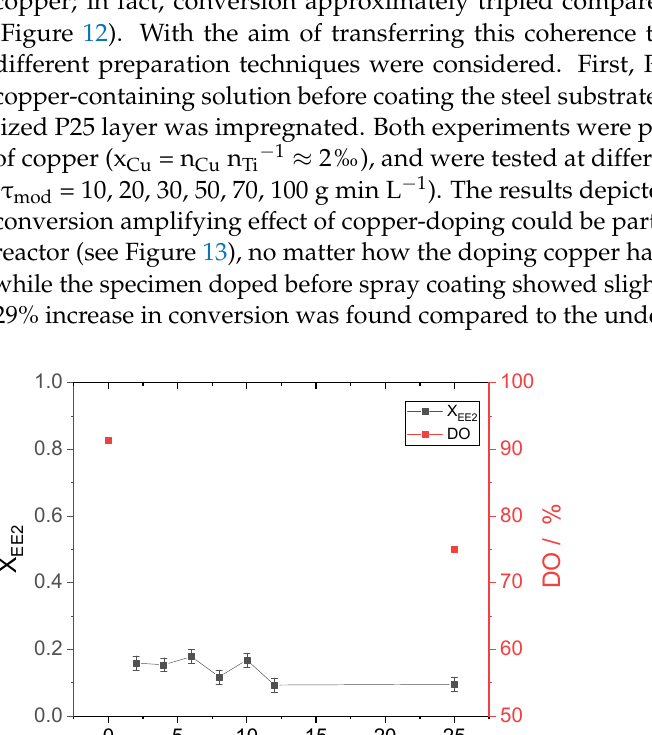
Figure 10. Reaction monitoring of the photocatalytic degradation of EE2 (17 α‐ ethinyl estradiol) and investigation of the influence of scavenger substances on the degradation kinetics. The experiment was carried out with a 60 ‐ fold parallel stirring UV ‐ A LED photoreactor system [29], in which each value resembles a separate catalytic experiment, with triple determination; V EE2 ‐ solution = 5 mL, c = 4.5 mg L − 1 ; scavenger additives: NaI, KBrO3, t ‐ butanol, c scavenger = 3 mmol L − 1 ; reaction parameters: cata ‐ lyst P25 (calcined), mP25 = 7.5 mg, f rot = 800 min − 1 , t dark = 30 min, E = 384 mW cm − 2 , λ = 365 nm; SPE ‐ GC ‐ MS analysis (determination of ion count n as a measure of the amount of substance from the extracted ion current (EIC), precursor ions: [M] + 440 m/z, [M ‐ 15] + 425 m/z; k(without scaven ‐ ger) = 0.012 s − 1 , k(KBrO 3) = 0.026 s − 1 , k(NaI) = 0.048 s − 1 , k(t ‐ butanol) = 0.004 s − 1 .